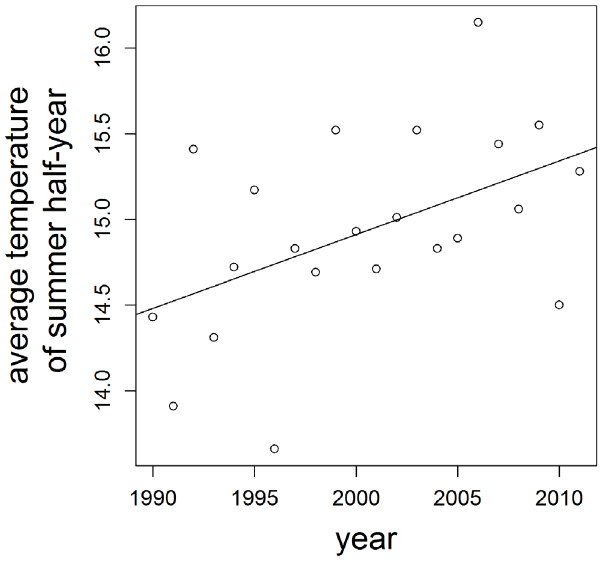
Figure 2. The average summer half-year temperature of the last 20 years in the